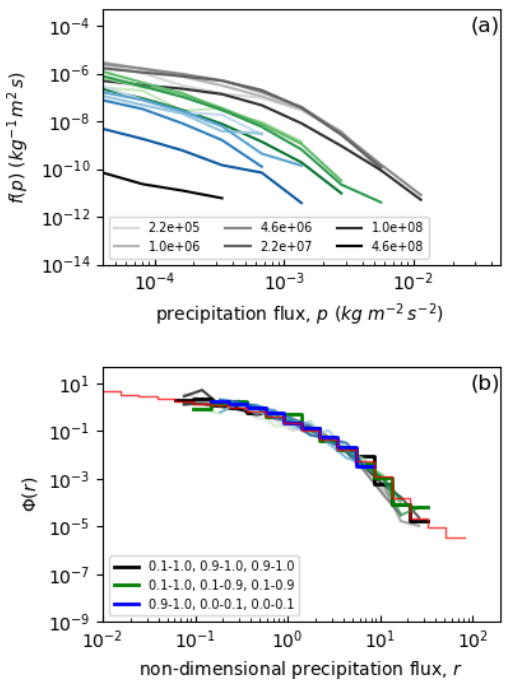
Figure 10. The CDNC dependencies of the rainfall rate distribu- tions in the 23 UK forecasts for three mid-latitude cloud regimes (deep frontal (black lines), low-cloud-dominated (blue lines) and in- termediate (green lines)). (a) The simulated rainfall rate frequency distributions, for each CDNC interval, for the three regimes of frac- tional cloudiness. The degree of shading for each colour shows the CDNCs. (b) The rescaled distributions (lines) and average universal histograms for each regime. The red line shows the non-dimensional distribution from the May 2016 subtropical case